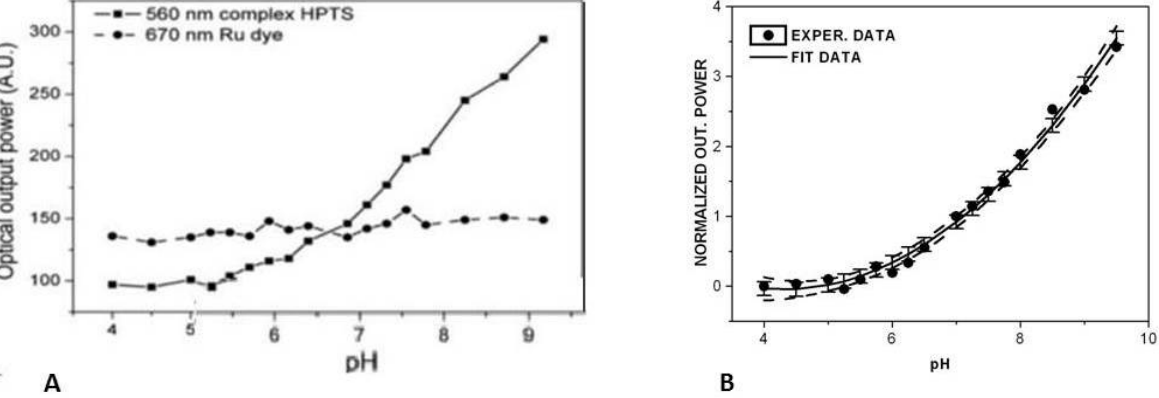
Figure 7. Calibration curves of the V-taper sensing probe in response to pH changes: ( A ) optical responses of the HPTS transducer and dichloro-tris-(1,10-phenanthroline)ruthenium (II) hydrate to pH; ( B ) calibration curve (including the upper and lower confidence limit dash lines [47,75]. Reproduced from [47] with the permission of CTU